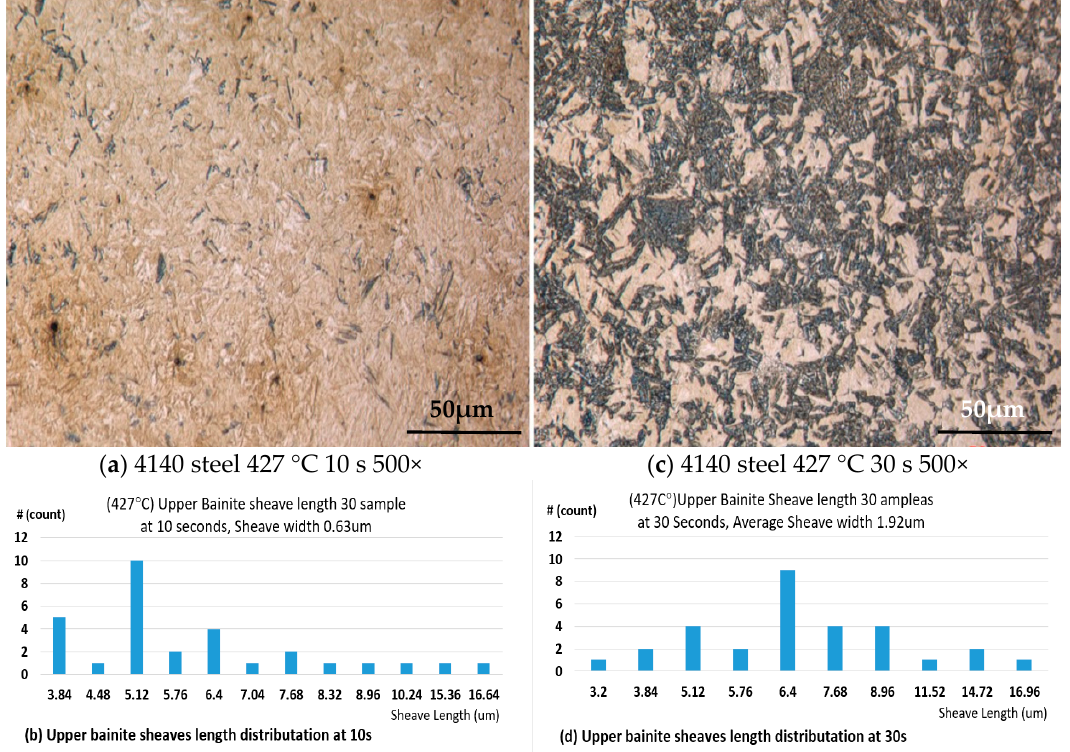
Figure 4. 4140 steel upper bainite microstructure and sheave length measurements during growth.